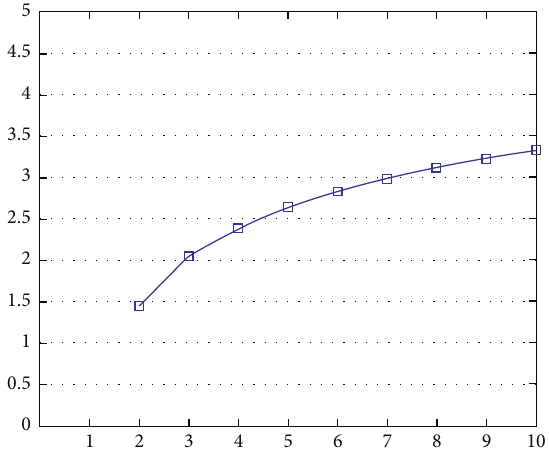
Figure 7: Randi´c entropy of HDN 1 ( n ) for α � − ( 1/2 ) .